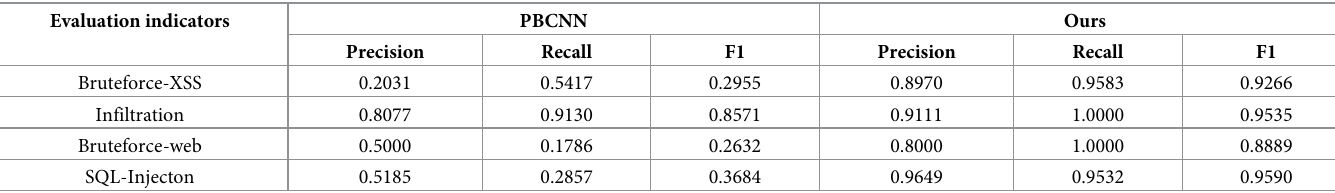
Table 3. Compare with